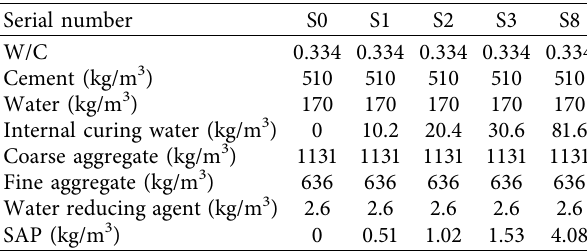
Table 2: Mixture proportions of